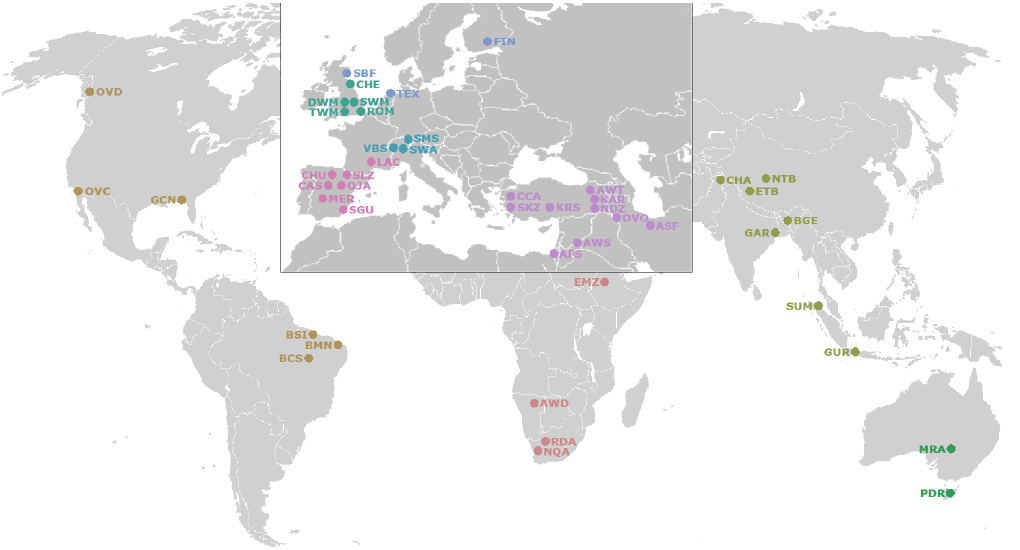
Figure 1. Location breed map. Geographic origin of the samples analyzed by whole genome resequencing (WGR) considered in this study including 151 samples from domestic sheep breeds and 24 samples from wild sheep. Breed and species names and their abbreviations are given in Table S1. In order to differentiate the geographical origin of the samples analyzed, the geographic area with the highest density of breeds analyzed (Europe and part of Asia) has been zoomed in.